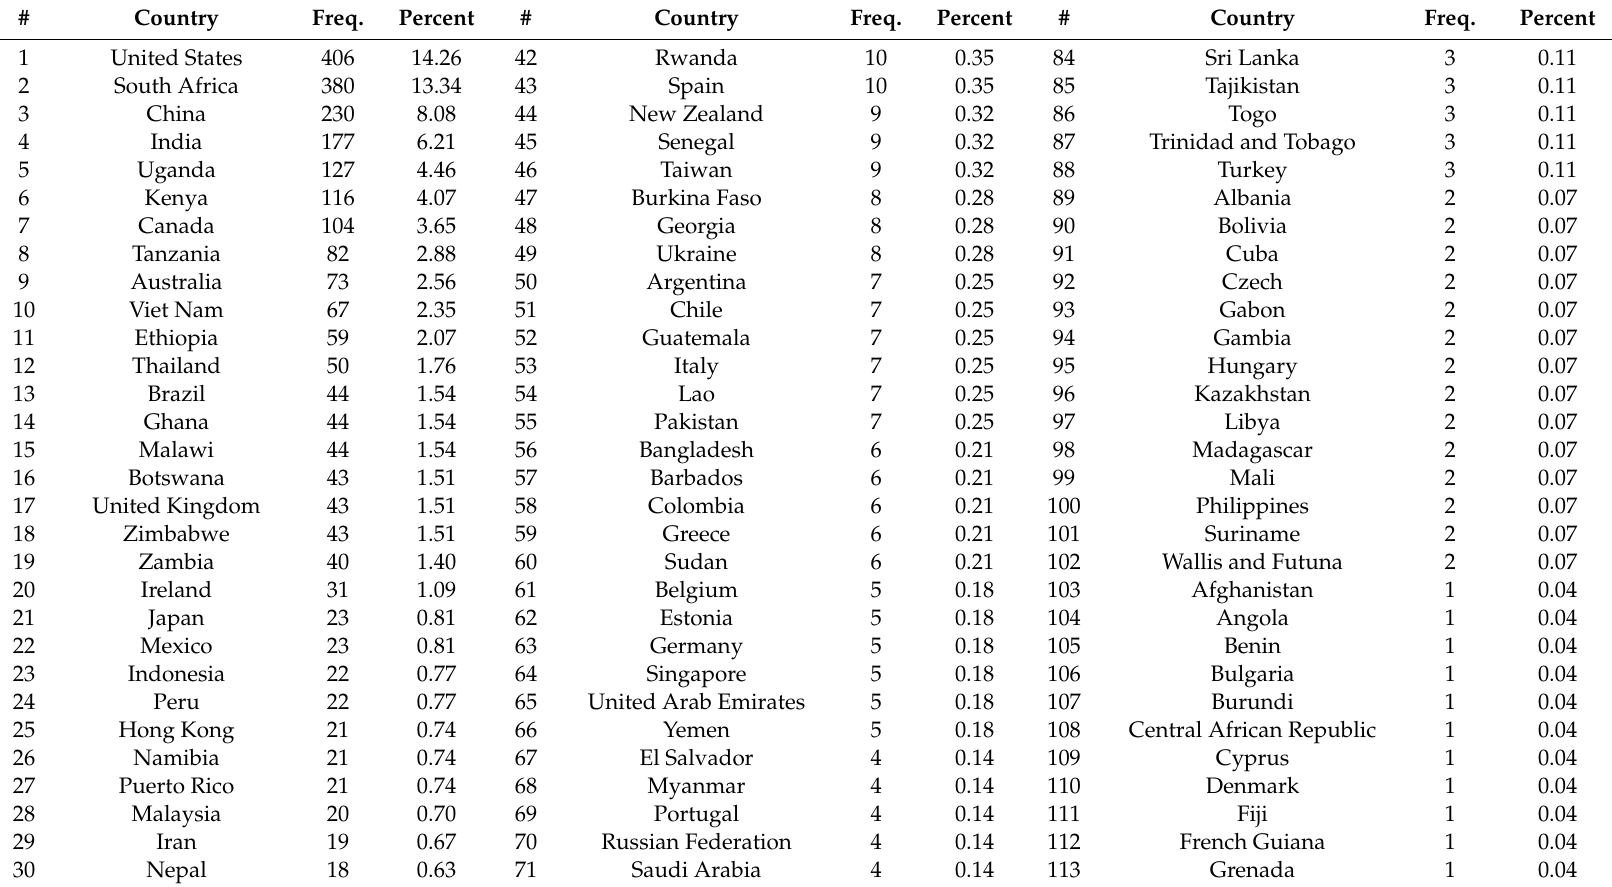
Table 2. Number of paper by study